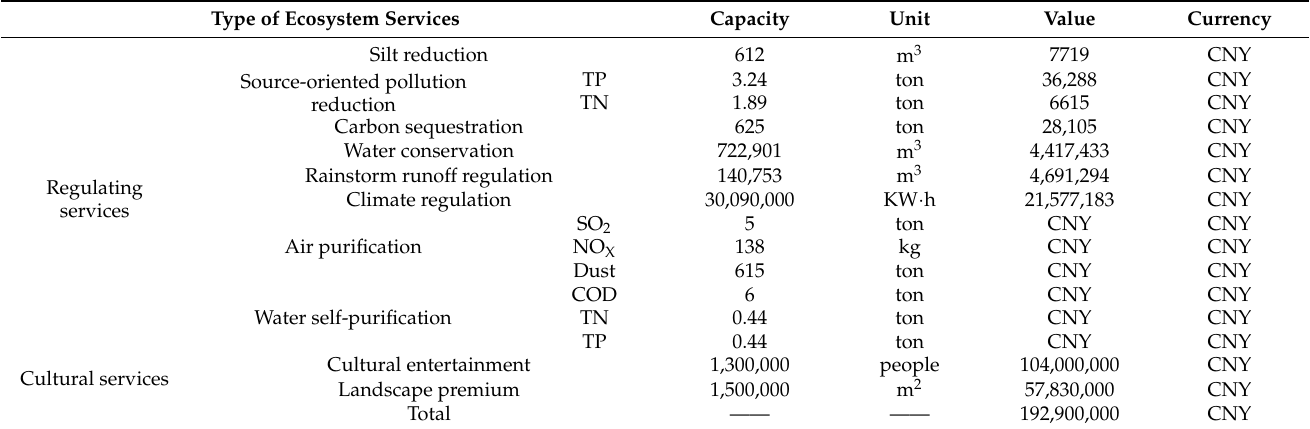
Table 1. Value of ecosystem services provided by Futian Mangrove Ecological